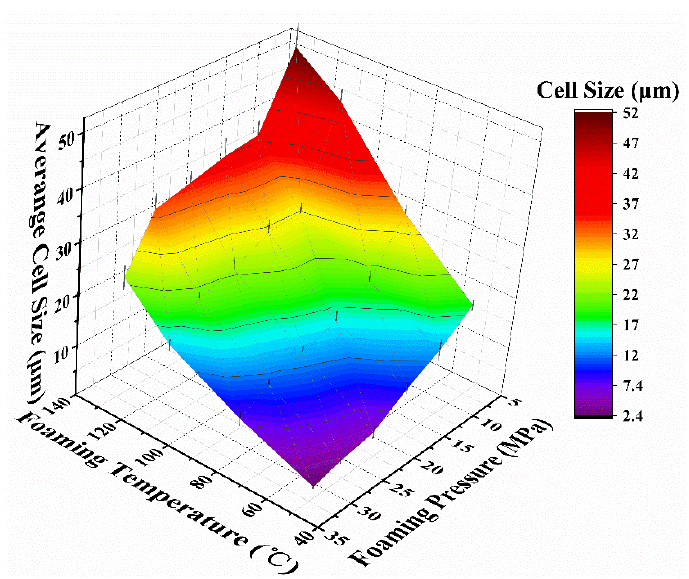
Figure 2. SEM images of typical foamed samples synthesized under various foaming conditions.